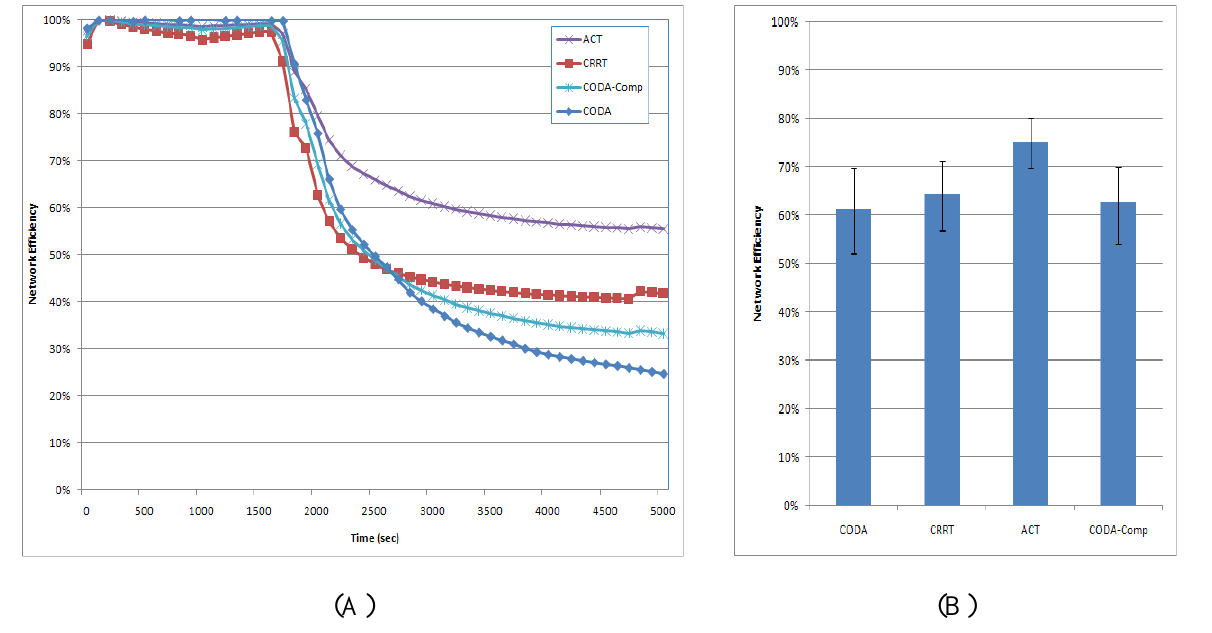
Figure 14. Network